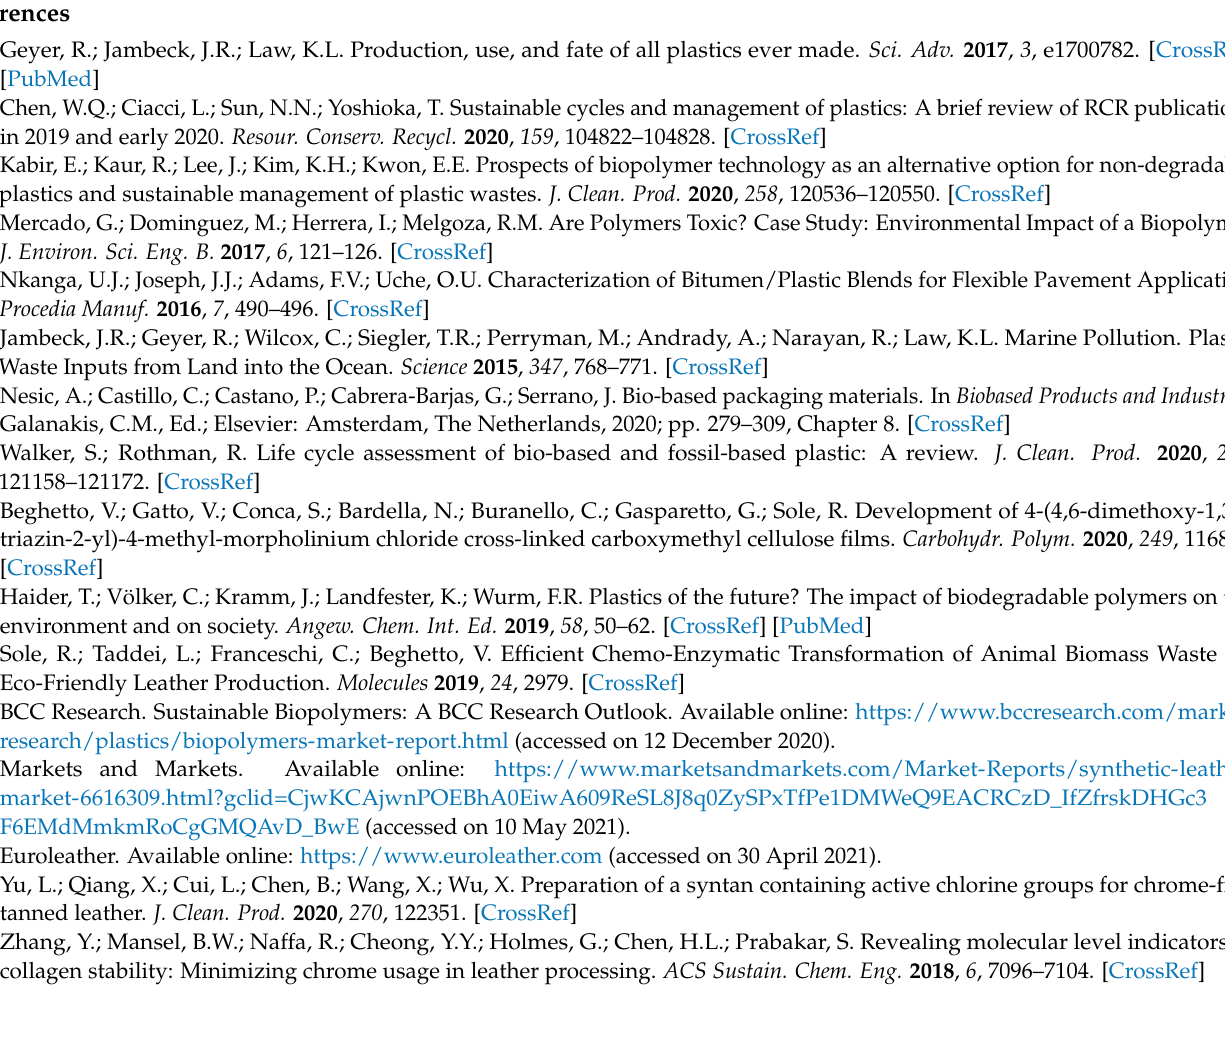
NMR spectrum of DET-MM (ClO 4 ) in D 2 O, Figure S3. FT-IR spectrum of DET-MM (ClO4) in KBr, Figure S4. 1 H NMR spectrum of DET-MM (BF 4 ) in D 2 O, Figure S5. 13 C NMR spectrum of DET-MM (BF 4 ) in D 2 O, Figure S6. FT-IR spectrum of DET-MM (BF 4 ) in KBr, Figure S7. DSC spectra of collagen cross-linking by a. CDET/NMM system and b. CDET/MPD